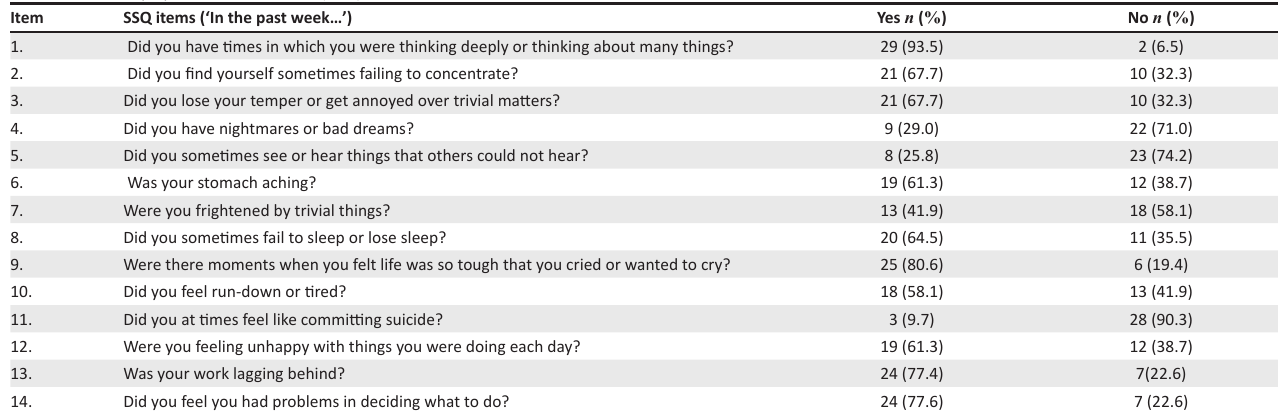
TABLE 2: Shona Symptom Questionnaire (SSQ) results.